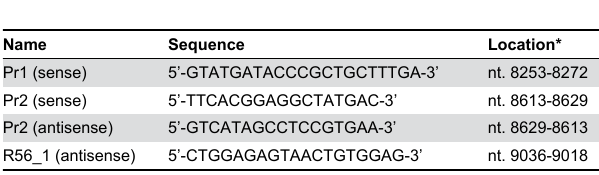
Table 6. Probes and primers for sequencing used in the present